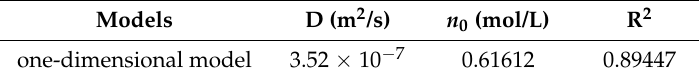
Table 2. The one-dimensional model of Fick’s second